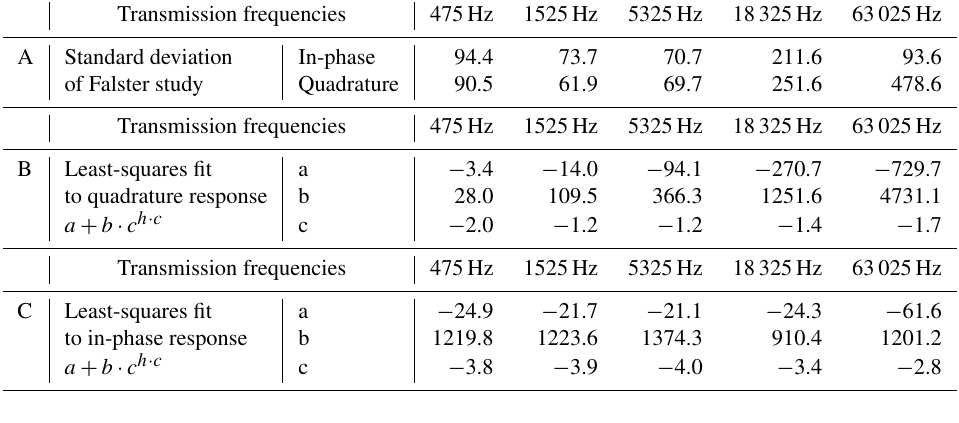
Table 3. (A) The calculated standard deviation of the Falster survey. The parameters a , b , and c shown in Fig. 11. Row (B) shows the parameters of the least-squares fit for the quadrature response, and (C) shows the parameters of the least-squares fit for the in-phase response.